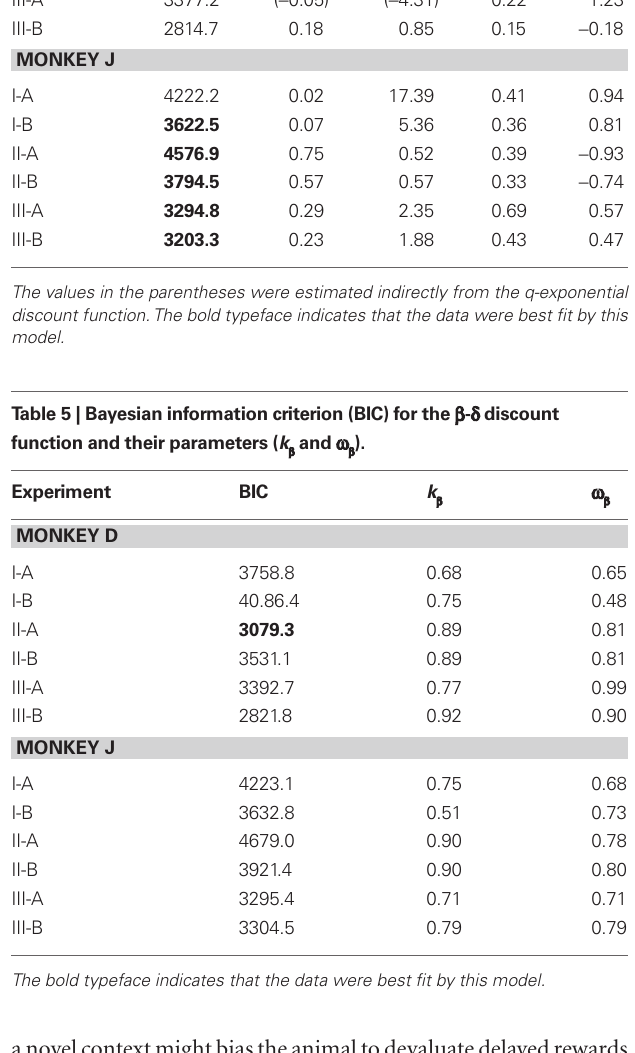
and g ) and the best G and q ). q